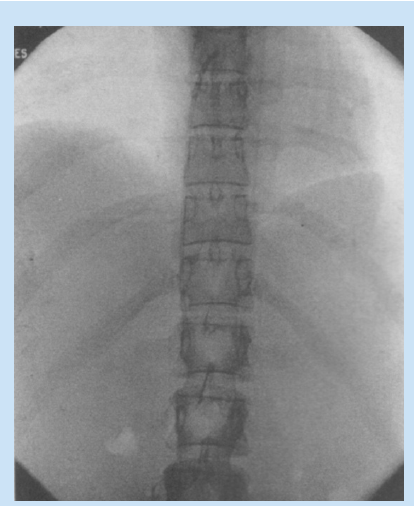
Fig. 1b. Lost central venous line in IVC and right